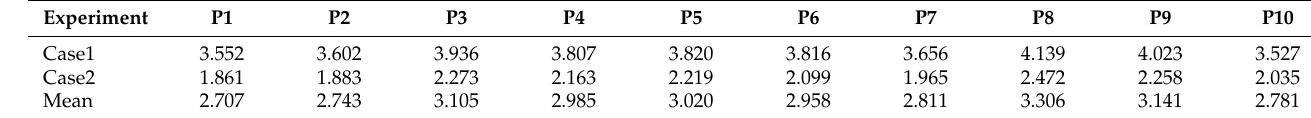
Table 8. Spatial averaged STD values for 24-h cumulative precipitation (mm) in the heavy rain area.